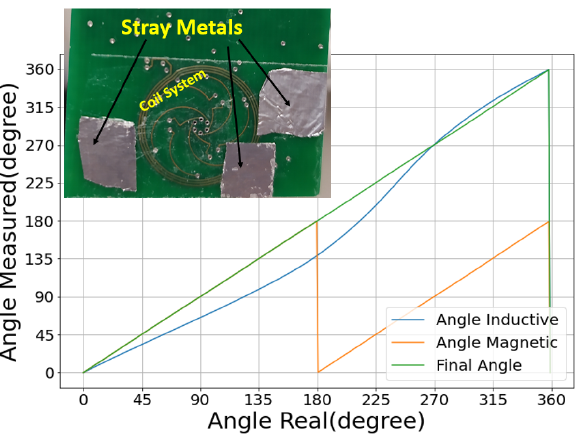
Figure 12. Angle response curves in the presence of stray metals. The inset is a picture of the experimental configuration showing the stray metals near or even overlapping the coil system. This pollutes the inductive sensor, yielding a substantial shift in the angle response curve of the inductive sensor. The final angle, however, is not